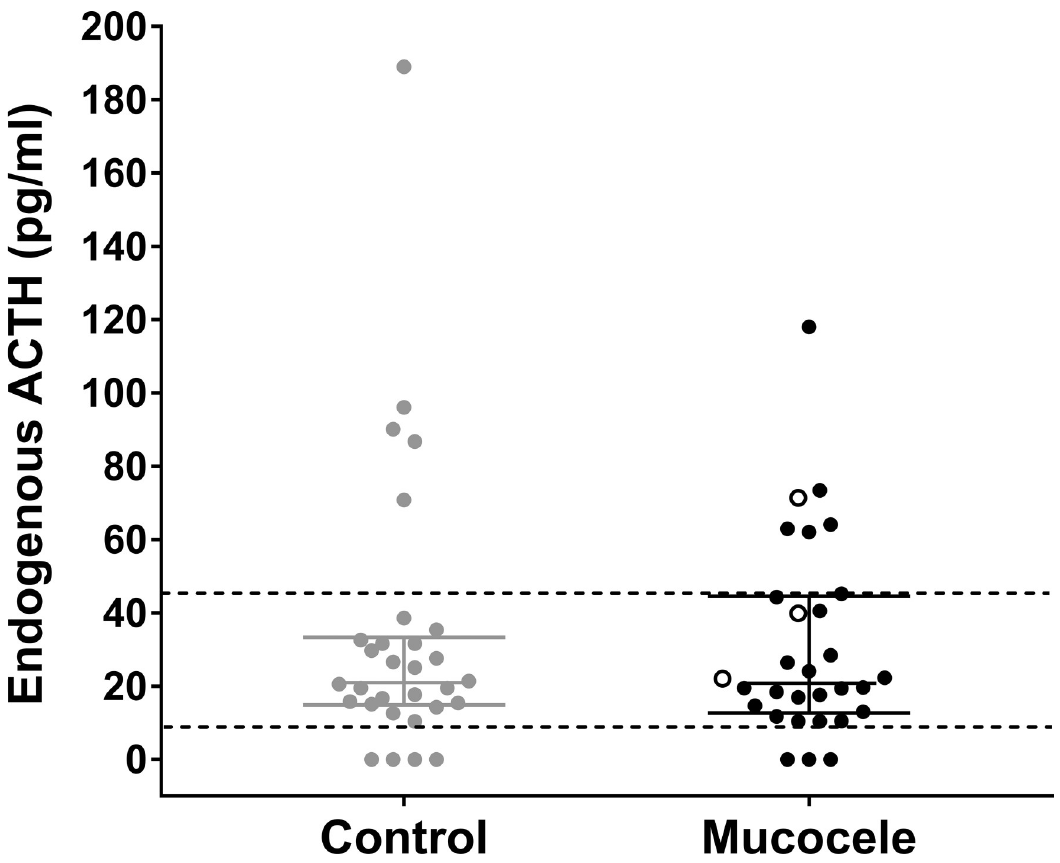
Fig 3. Plasma ACTH concentration in control dogs and dogs with gallbladder mucocele formation. Data represent individual dogs with reference range limits shown as dashed lines. Bars represent median and interquartile range. Open circles represent dogs with gallbladder mucocele formation that had concurrent post-cosyntropin serum cortisol concentrations above the calculated reference range (as shown in Fig